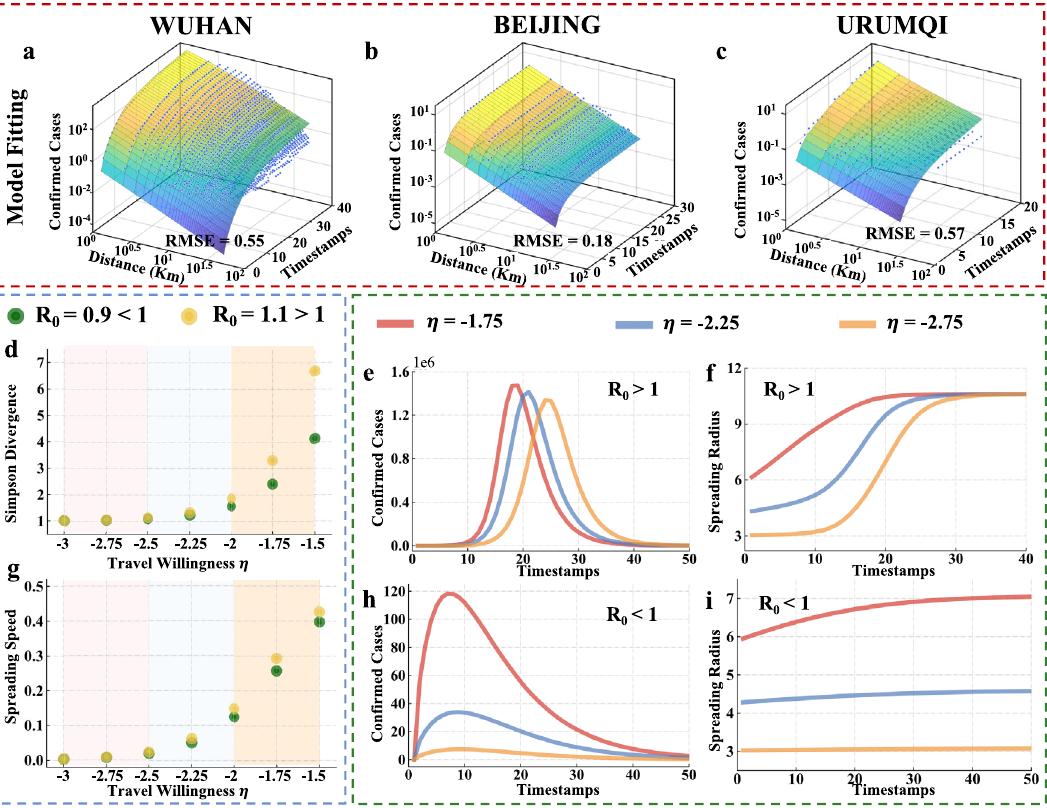
Fig. 3 The spatial-temporal model for COVID-19 spreading pattern. a – c The overall model fi tting performance. d Relation between travel willingness η and Simpson divergence. e , h Relation between travel willingness η and daily reported con fi rmed cases. g Relation between travel willingness η and the growth rate of spreading radius. f , i Relation between travel willingness η and spreading